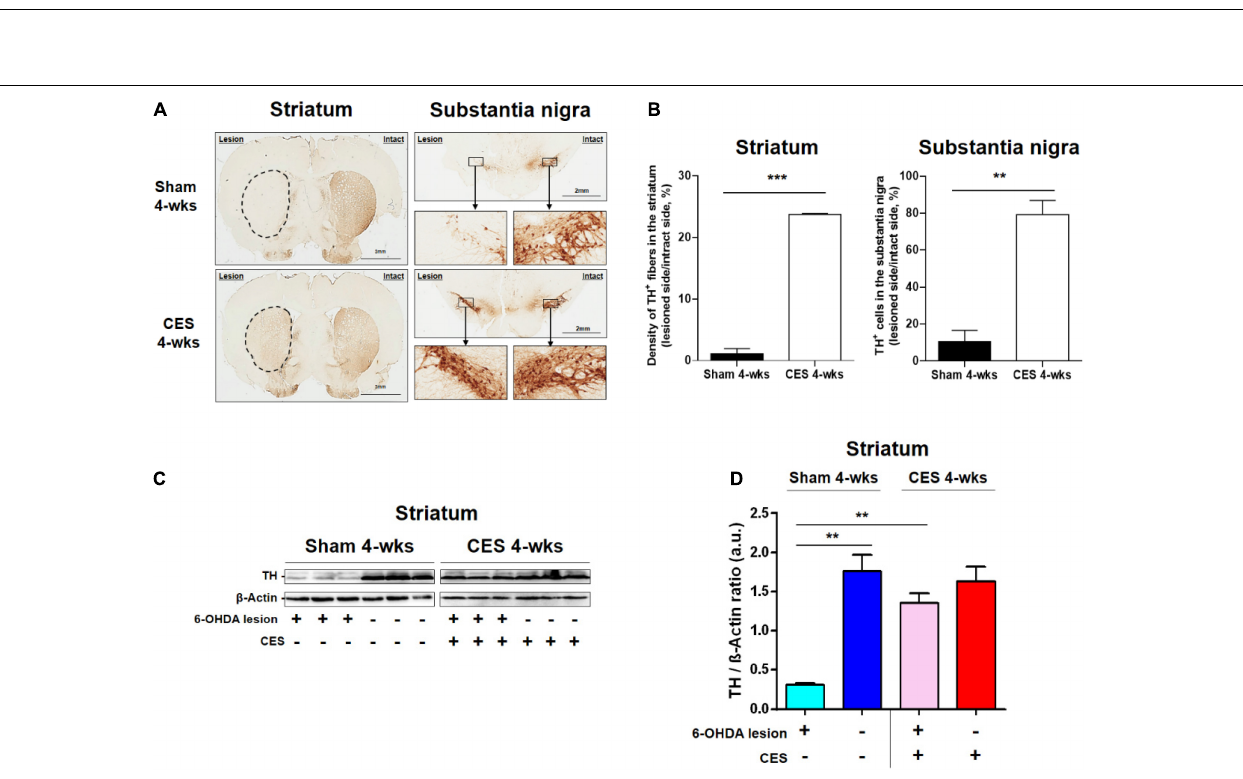
FIGURE 7 | (A) Representative TH-positive fibers in the striatum and TH-positive neurons in the substantia nigra pars compacta from the sham-treated and CES-treated rats at 4 weeks after PD lesion. (B) Comparison of the average TH-positive fibers and neurons between sham and CES treatment groups. (C) Expression of TH in the striatum represented through a western blot for PD rats that received sham ( n = 3) and CES ( n = 3) treatments at 4 weeks after PD lesion. (D) Quantitative analysis of relative protein levels of TH in the striatum in the sham and CES treatment groups. ** p < 0.01, *** p < 0.001, each of which indicates a significant difference between the two